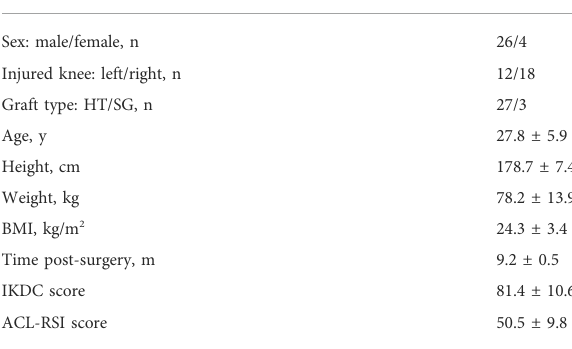
TABLE 1 Participant